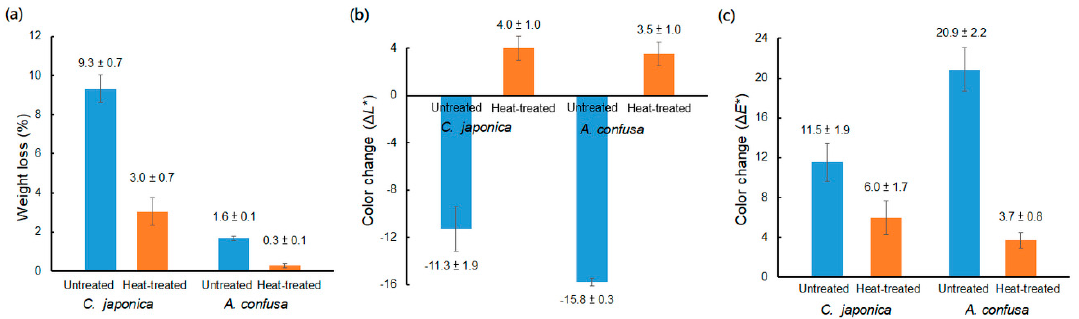
Figure 6. Weight loss ( a ) and color changes ( b – c ) of untreated and heat-treated Japanese cedar ( Cryptomeria japonica ) and Formosa acacia ( Acacia confusa ) wood after the 50-day decay resistance test.